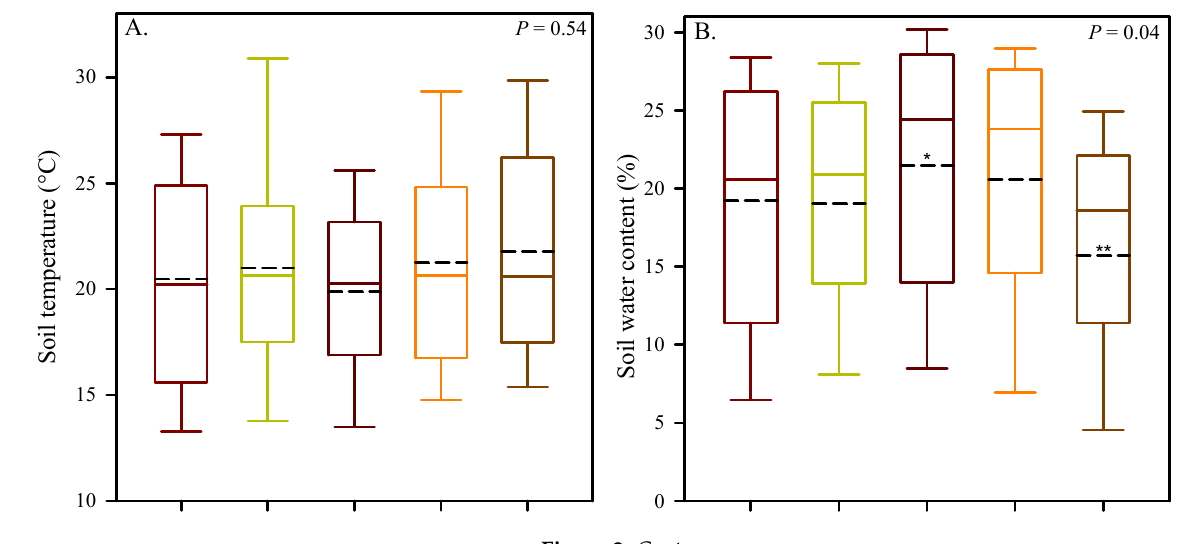
Figure 2. Box-whisker plots for soil temperatures ( A ), soil water content ( B ), penetration resistance ( C ) and soil bulk den- sity ( D ) at 0.05 m soil depth from conventional tillage with free grazing (CTFG), no-tillage with free grazing (NTFG), no- tillage with no grazing (NTNG), no-tillage without crop residue mulching (NTNR) and no-tillage with controlled grazing (NTCG). Plain lines correspond to 10th, 25th, median, 75th , and 90th percentiles; short dash lines to the mean. Significant differences from NTCG mean as a control to the other treatments indicated by *, **, ***, representing p value of < 0.05, <0.01, 0.001, respectively. N = 120, 27, 45, for soil temperatures, soil water content, penetration resistance, and soil bulk density, respectively.